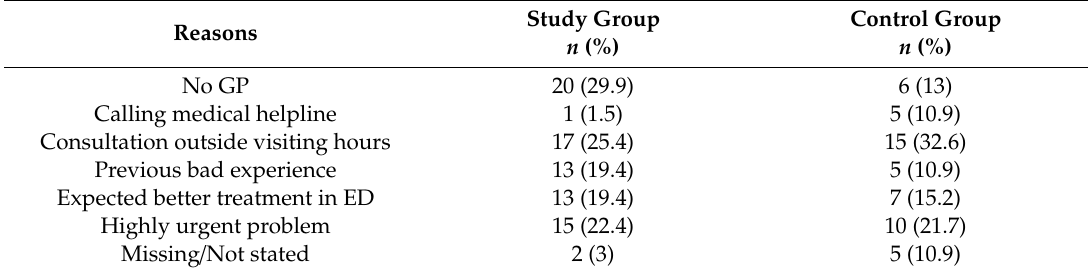
Table 2. Reasons why patients did not try to or use GP before presenting to the emergency department. (Patients with direct ED consultation N-AS: 67; N-CG: 46; multiple answers possible.)